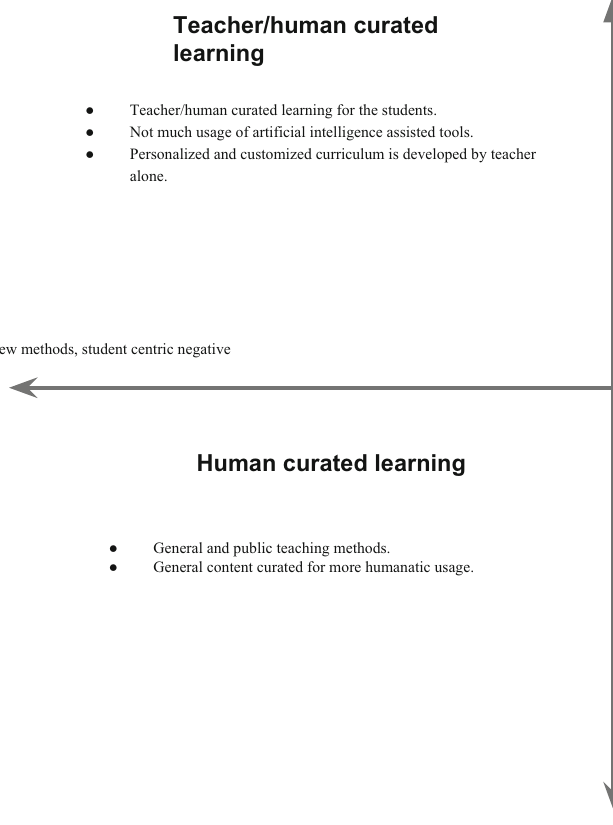
Fig. 5 Example for building primary scenarios using